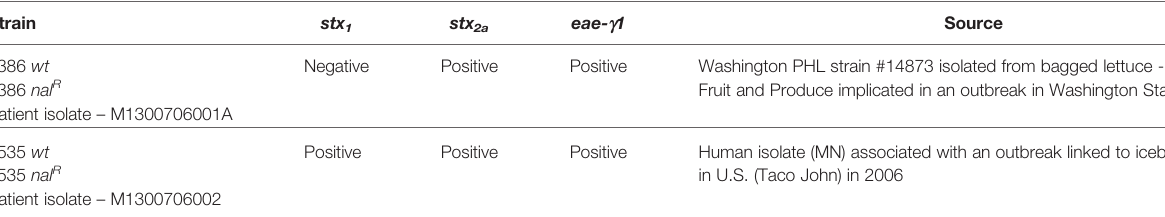
TABLE 1 | Laboratory and patient E. coli O157:H7 strains used in this study.